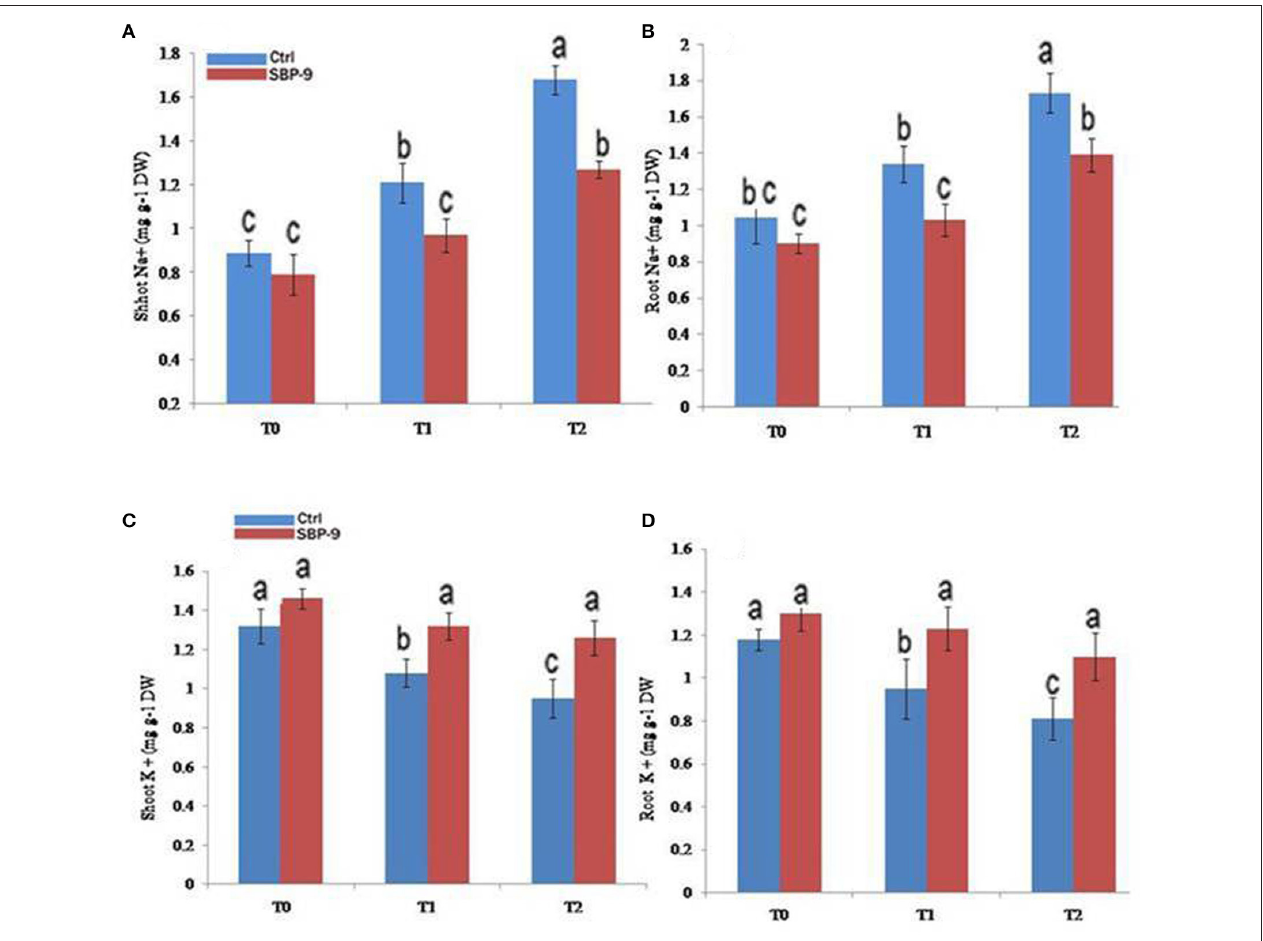
FIGURE 4 | Effect of NaCl and inoculation with SBP-9 on ionic uptake by plants under different treatments T-0, T-1, T-2; (A) Shoot Na + (B) Root Na + (C) Shoot K + (D) Root K + . Values are mean ± SD of triplicate sets of five measurements in triplicates ( n = 15). Different letters on the bar in each column represent the significant